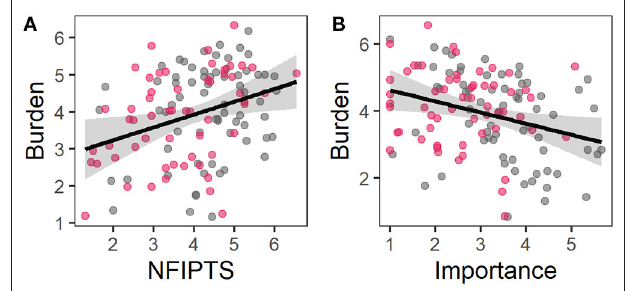
FIGURE 5 | Partial residual plots of regression model 3; the observed data is based on the values of (A) need for interpersonal touch scale and (B) importance of touch and the model error. The grey area represents the confidence interval, grey dots data of HC and red dots data of BPD.